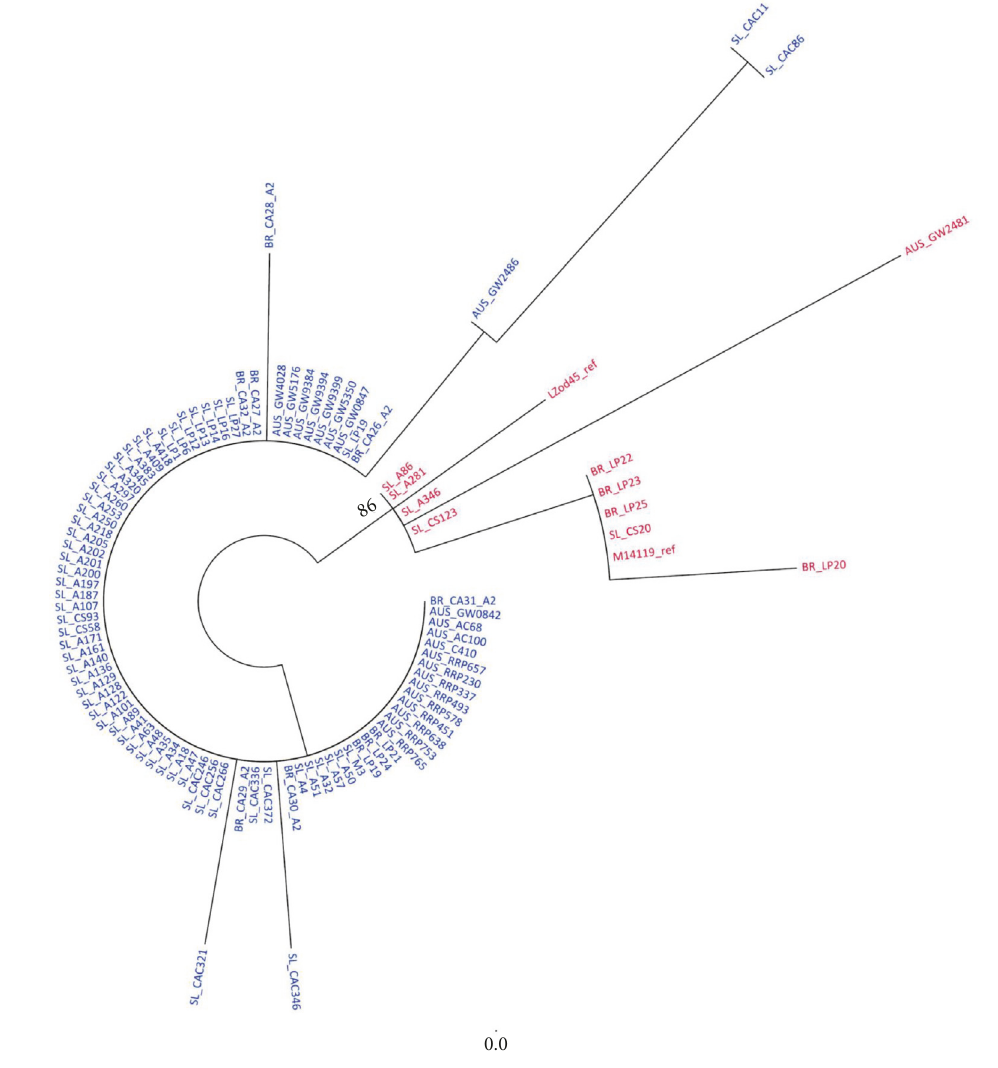
Figure 2: Unrooted maximum likelihood phylogenetic tree for HPV11 reconstructed based on a dataset of 101 nucleotide sequences of 453 residues with the TrN + I +G substitution model and a bootstrap of 1000 replicates. Values above 70% were considered significant. (Australian variants: AUS; Brazilian variants: BR; Slovenian variants: SL.) Red: HPV11A1; blue: